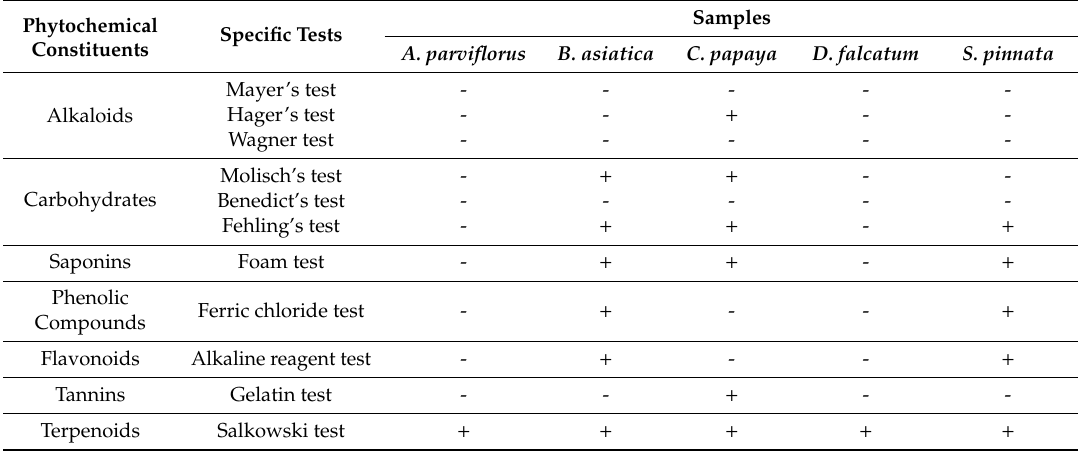
Table 2. Phytochemical constituents identified in di ff erent plant